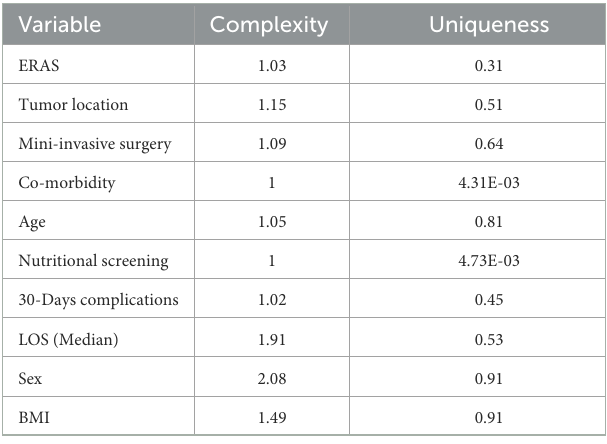
FrontiersinNutrition